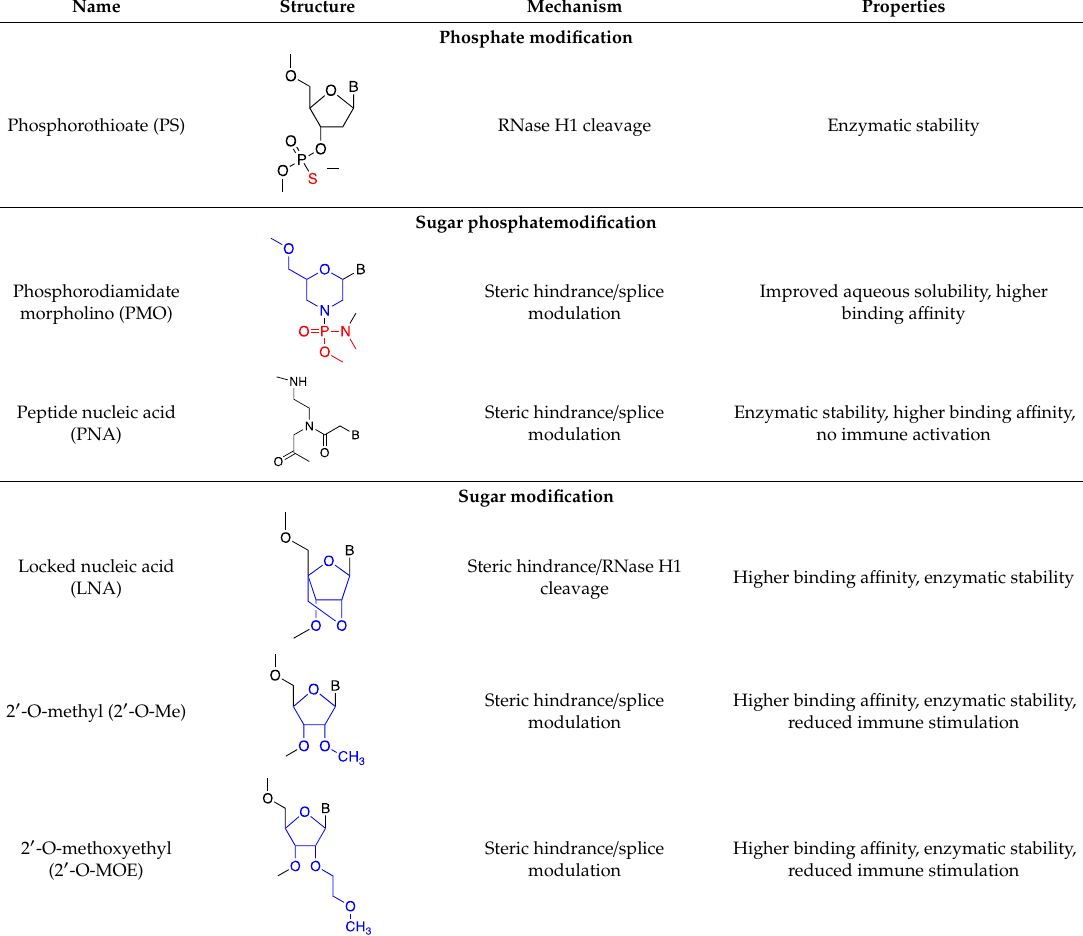
Table 1. Chemical modifications of antisense oligonucleotides (ASO).